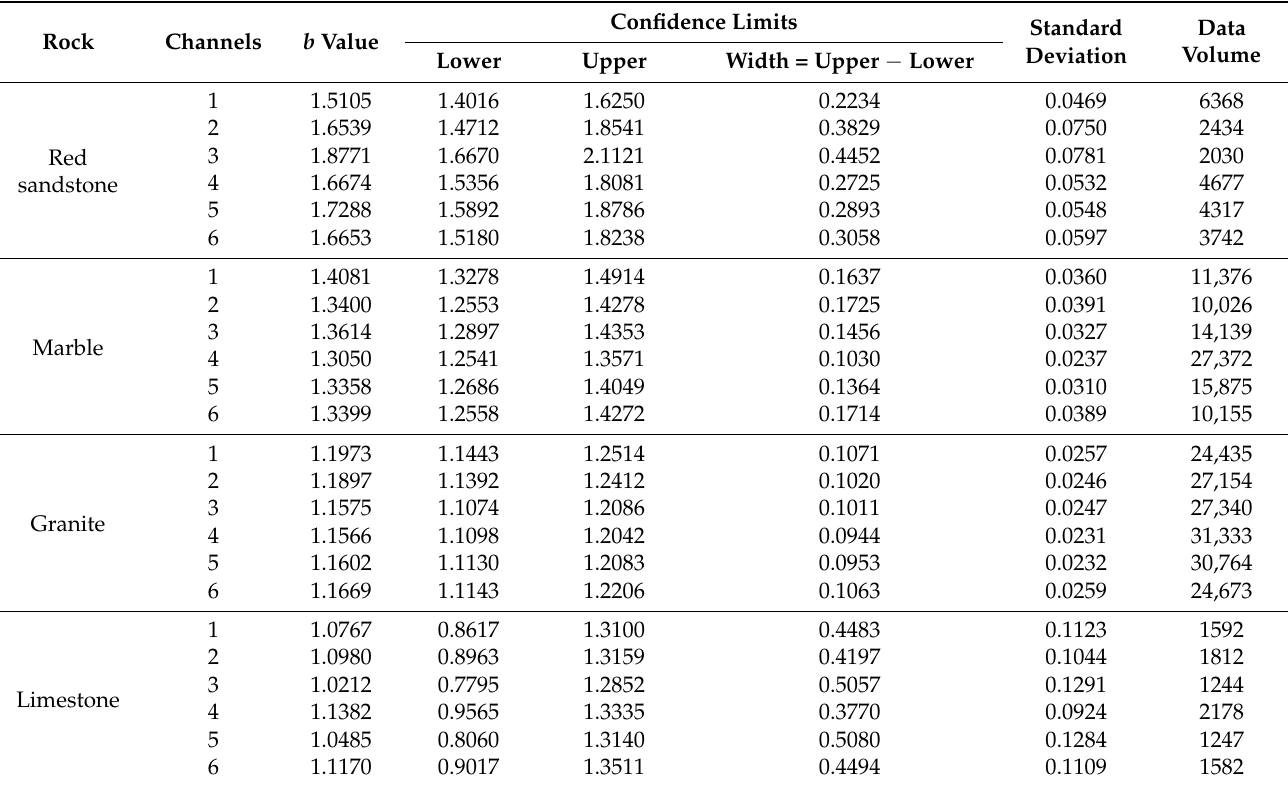
Figure 5. The MLE b values and confidence limits in DTFAD of red sandstone, marble, granite and limestone. The b values and confidence limits are calculated for each of the 6 channels of each rock. The bars of different colors are confidence limits of the b value. Table 2. MLE b values and confidence limits in DTFAD for different types of rocks.